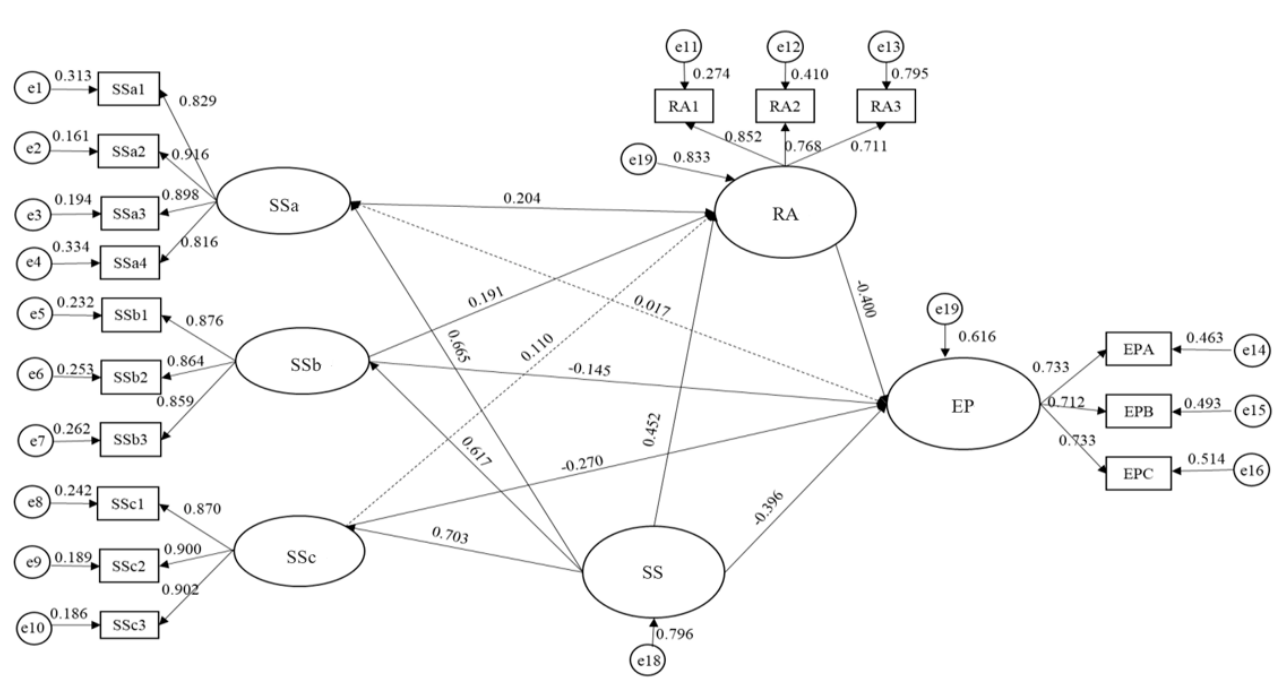
Figure 2. Path Results of Structural Equations.